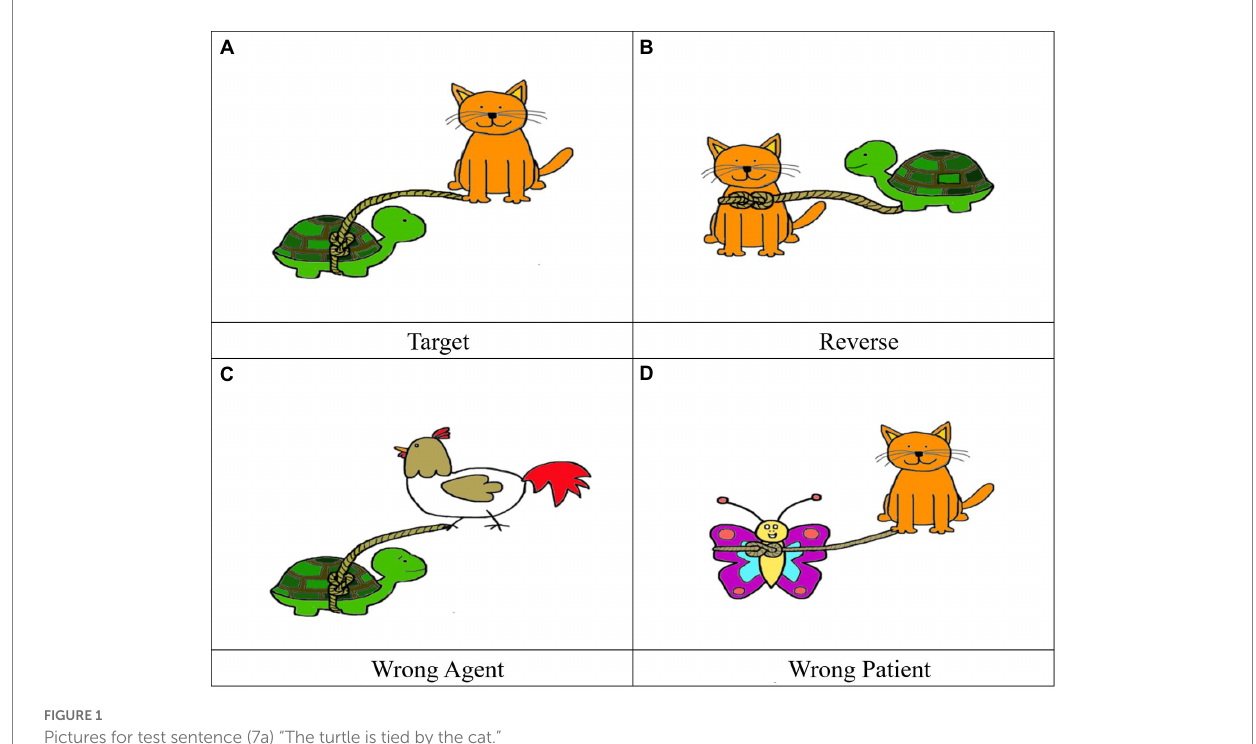
FIGURE 1 Pictures for test sentence (7a) “The turtle is tied by the cat.”